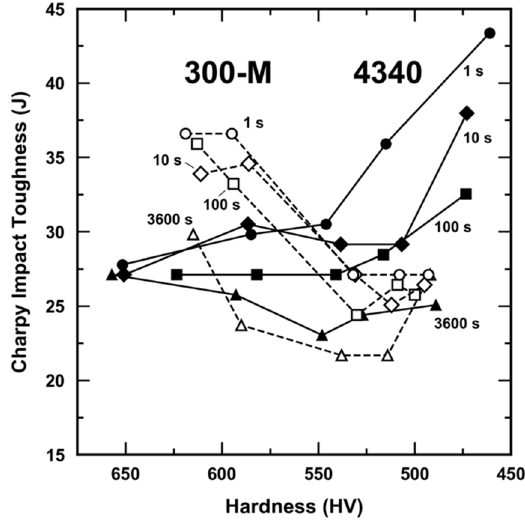
Figure 2. Room temperature impact toughness of 1, 10, 100, and 3600 s time conditions of 4340 (closed) and 300-M (open) as a function of tempered hardness. Represented data are the average of two tests.